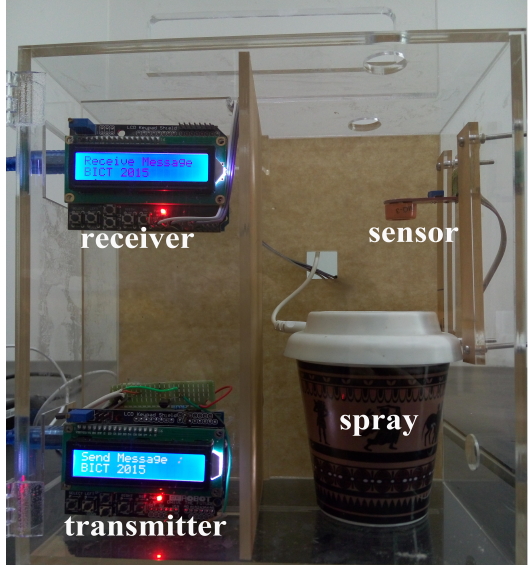
Figure 3. A test-bed for vertical molecular communication As can be seen, the main parts of Ares is wrapped by the acrylic glass. In order to make the construction of Ares clearly shown, we draw a craft of the test-bed, which is shown in Figure 4. Ares is mainly consists of the transmitter, the receiver, the spray, and the alcohol sensor.